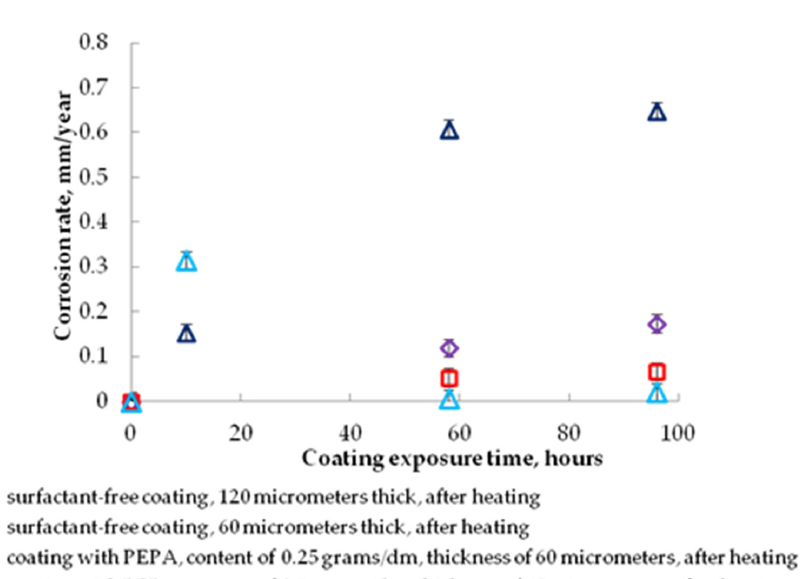
Figure 5. The effect of the surfactant content (CS) on the corrosion rate of the coating obtained from the recommended enamel.